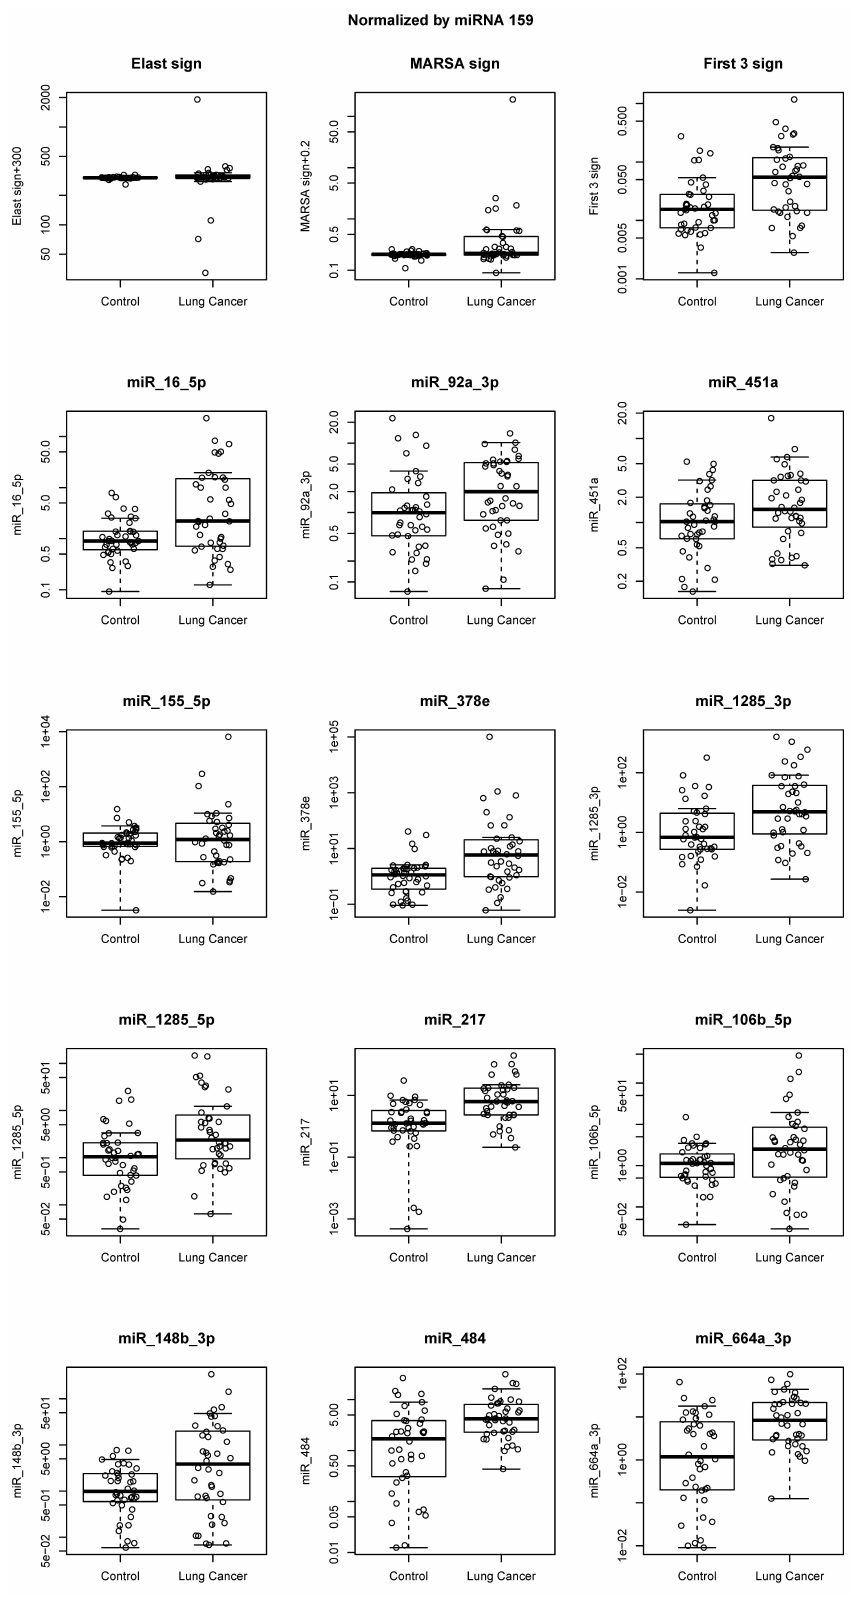
Figure 3. Validation data showing miRNA levels in the signatures (Elastic net, MARSA, and C-Statistics) and individual miRNA levels for the first three C-Statistics miRNAs: miR-16-5p, miR-92a-3p, and miR-451a, aswellastheremainingmiRNAs(miR-155-5p, miR-378e, miR-1285-3p, miR-1285-5p, miR-217,